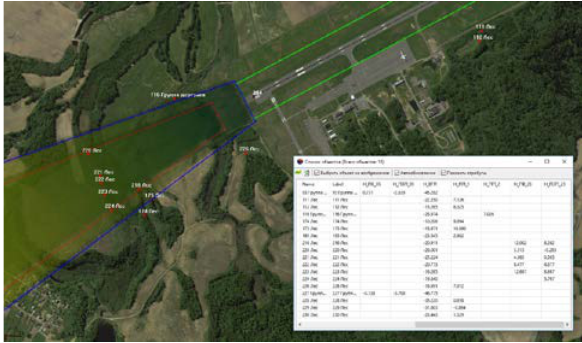
Figure 4. The take-off climb surface 3D dense model and a vector attribute